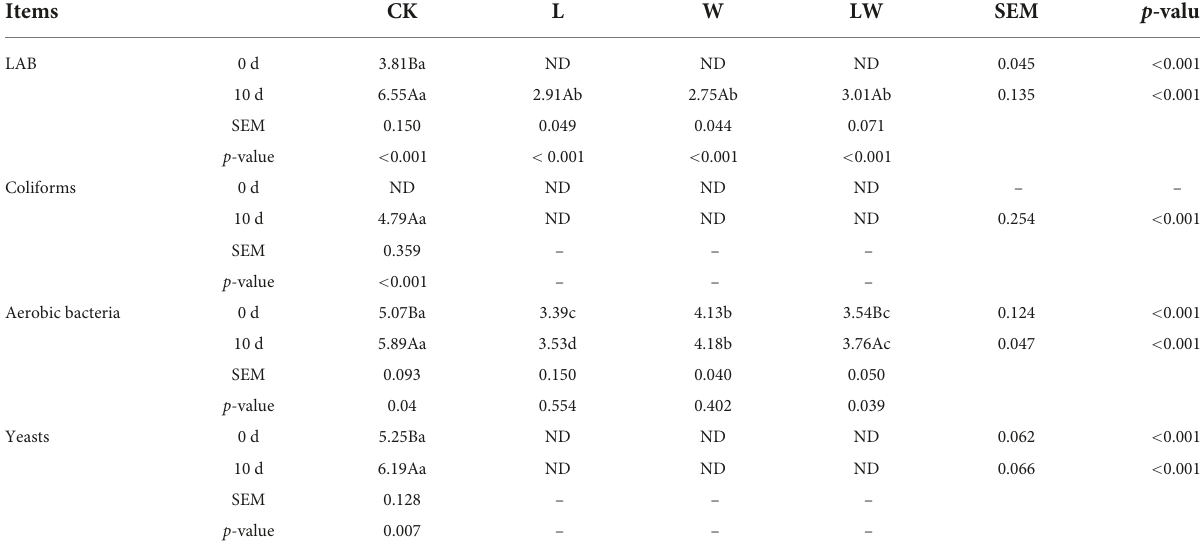
TABLE 3 Microbial counts (log colony-forming units/g fresh weight) in Leymus chinensis silages ( n = 3). Items